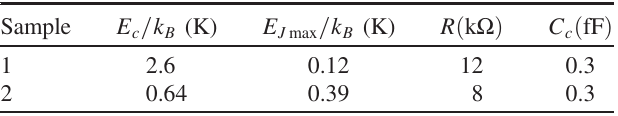
TABLE I. Main sample parameters. See Appendix B for details on their